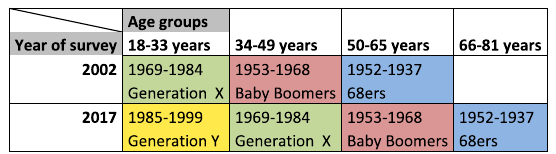
Table 2 Cohorts (generations) und age groups Table 3 Descriptive